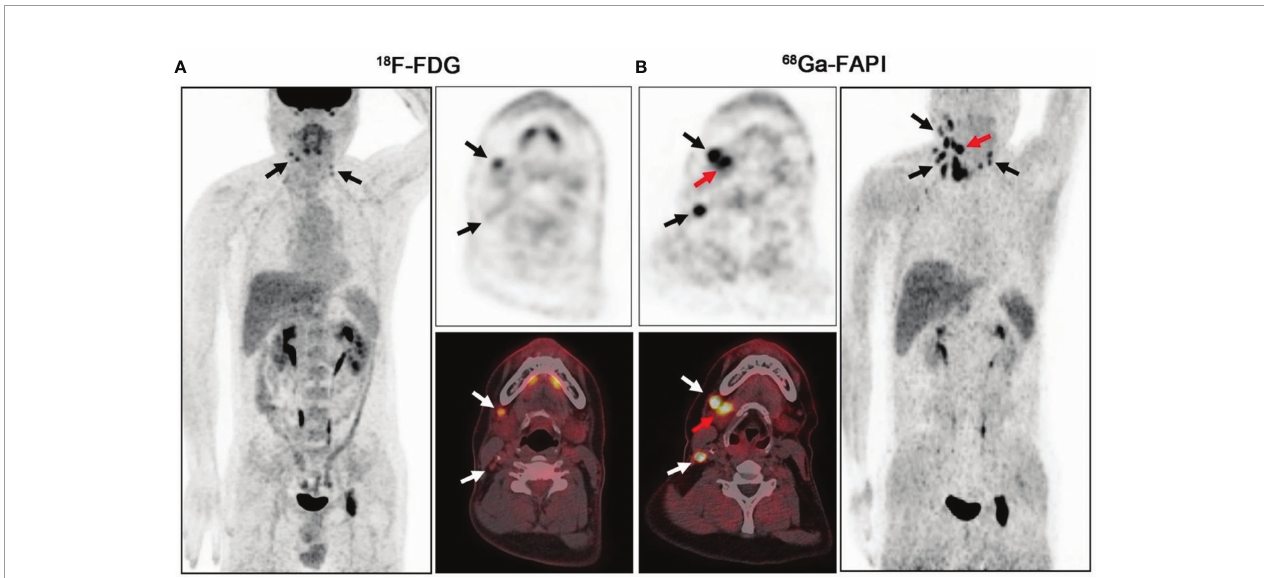
FIGURE 4 | PET/CT scans of 18 F-FDG (A) and 68 Ga-FAPI (B) in a 41-year-old patient with lymph node metastasis from salivary gland ductal carcinoma. 18 F-FDG- PET/CT was negative for the primary tumor. On 68 Ga-FAPI-PET/CT, the right submandibular gland shows strong uptake ( B , red arrow; SUVmax = 15.80), whereas the left submandibular gland has low background uptake (SUVmax = 6.87) (black and white arrows indicate lymph node metastases)